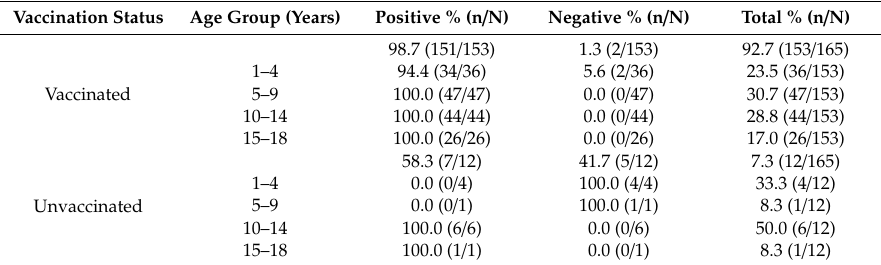
Table 2. Vaccination status and seroprevalence assessment of the enrolled subjects.